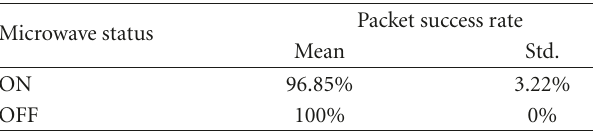
Table 3: Coexistence test results between IEEE 802.15.4 and microwave oven.